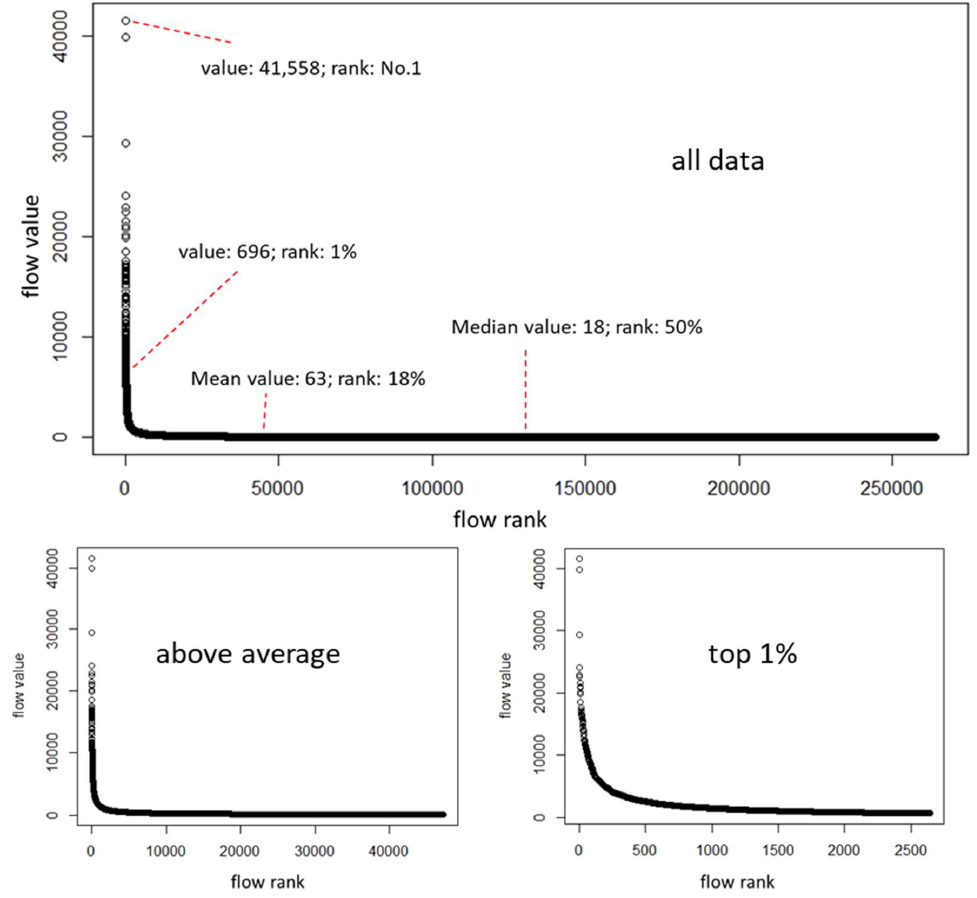
Figure 1. Heavy-tailed distribution of U.S. migration flows.